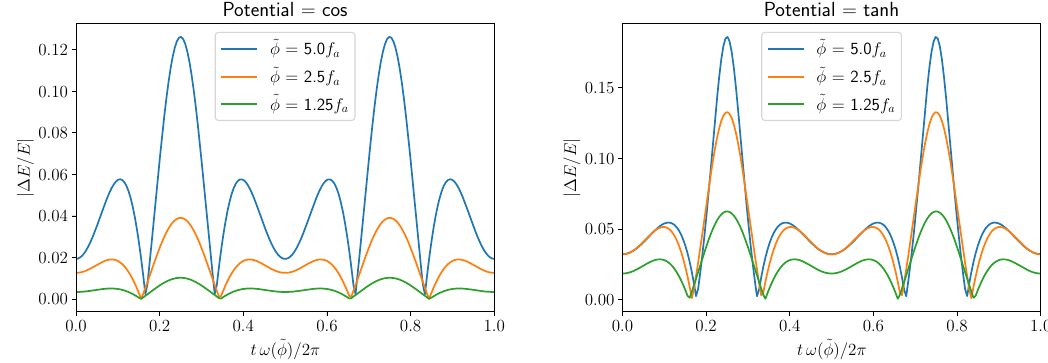
Figure 5 . The figure shows the variation in energy E computed using eq. (5.3) and its time average h E i computed using (5.4) for the ansatz in eq. (3.1). | ∆ E different values of the central amplitude ˜ φ